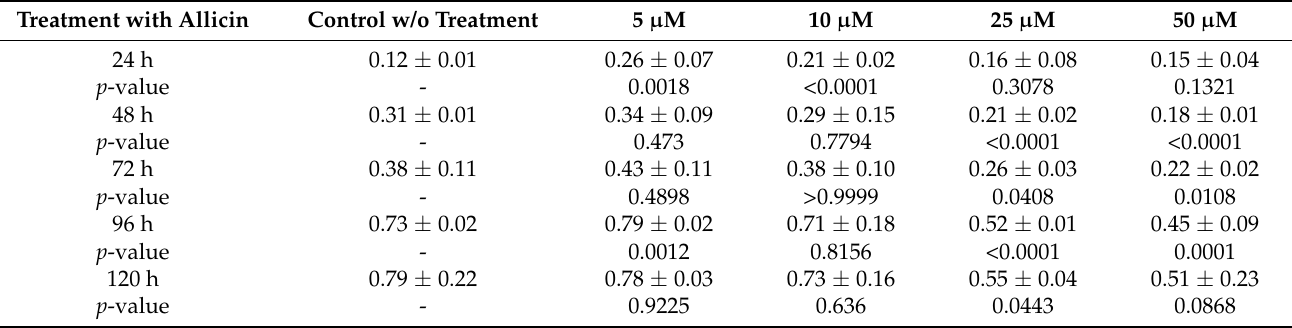
Table 6. TIM-3 gene expression in 2 µ L/mL GCF-treated CD3+ T cells treated with different concentrations of allicin (Mean ± SD).